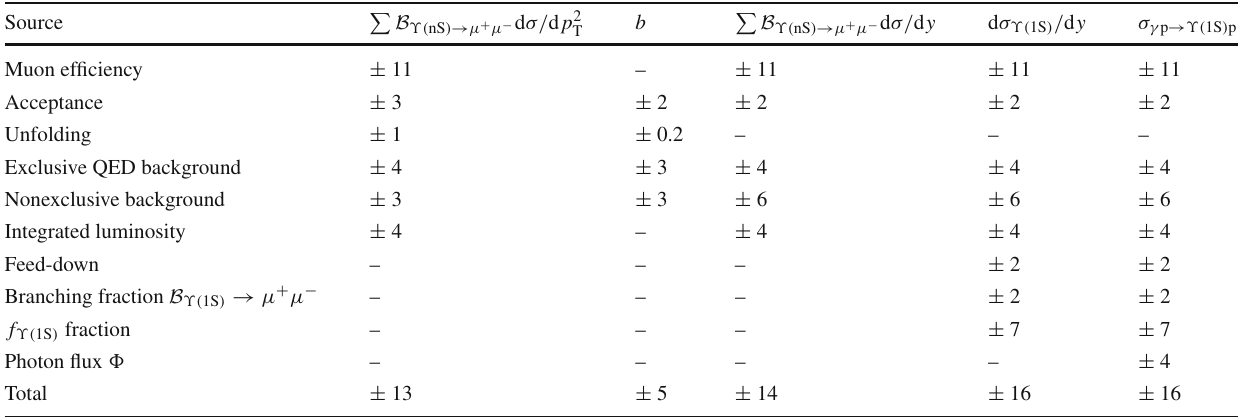
Table 1 Relative systematic uncertainties in percent in the measure- (cid:5) σ/ d p 2 B ϒ( ments of , the exponential b slope of the p 2 nS ) → μ + μ − d T